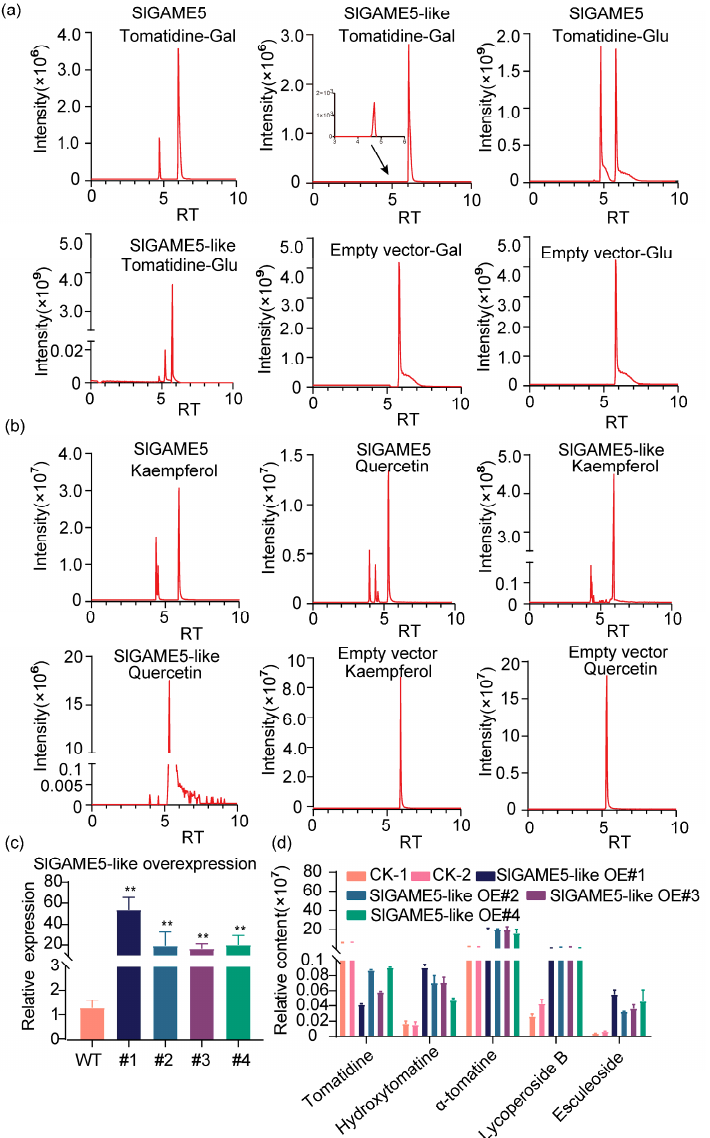
Figure 3. Enzymatic assays of recombinant GAME gene products in vitro. ( a , b ): Analysis of recombinant SlGAME5 and GFP-SlGAME5-Like enzymatic reaction products. ( c ): SlGAME5-like expression levels in three independent transgenic lines as determined by real-time PCR analysis. ( d ): SlGAME5-like plants showed increased accumulation of lycopene and its precursor. The absolute concentrations of lycopene and its precursor were determined in fully expanded leaves from four-week-old seedlings using UPLC-qTOF-MS and compared with those of wild-type plants of the same age. Data were from three independent experiments and expressed as means ± SD. ( n = 3). The differences were analyzed in two tailed comparisons with the control, and ** p < 0.01 in the student’s t -test.